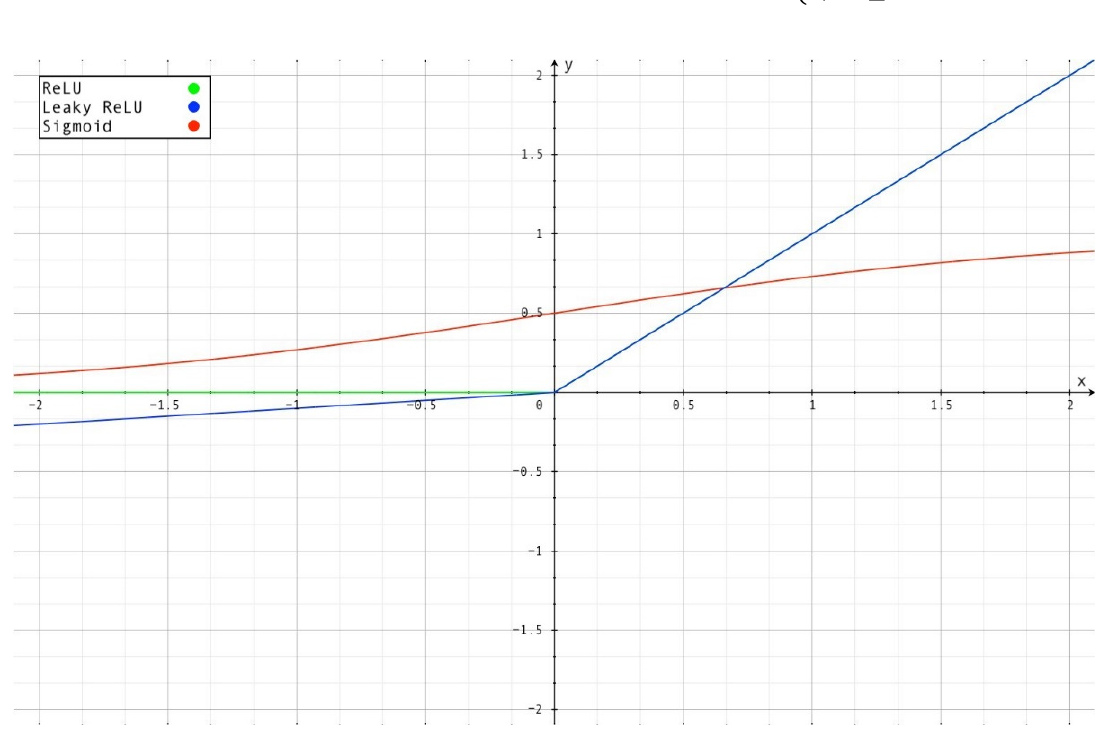
Figure 4. Activation functions.